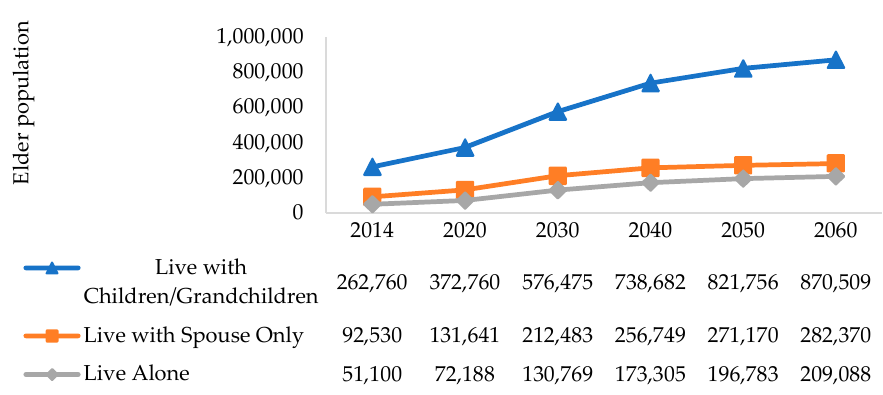
Figure 3. Projected number of elders by living arrangements over 40 years until